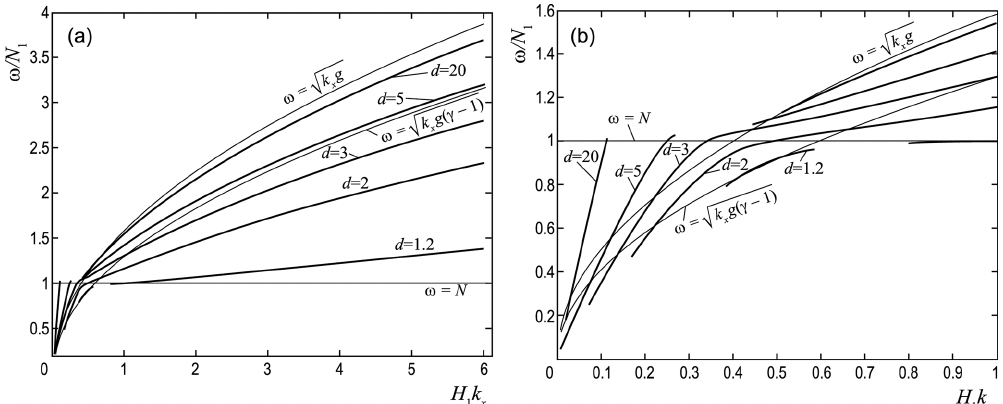
Figure 2. Dispersion dependencies ω = f (k x ) at the boundary of the discontinuity for different values of the parameter d . General depen- dence (a) , long-wave part in more detail (b)